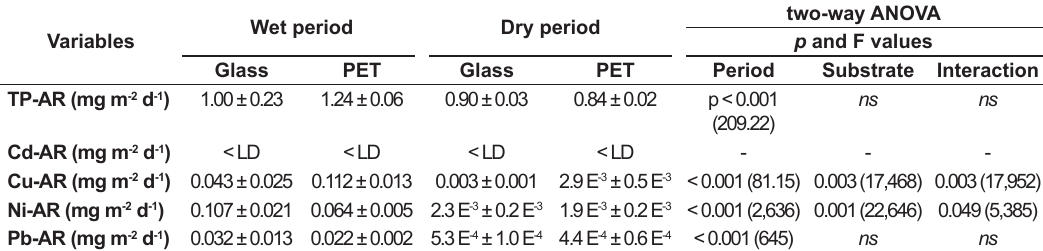
Figure 3. (A) Total phosphorus, TP; (B) Copper, Cu; (C) Nickel, Ni; and (D) Lead, Pb accumulation rates (mg m -2 d -1 ) on periphyton dry mass over glass and PET substrates in the wet and dry periods. Cd was bellow detection limit (0.003 mg L -1 ). Different letters indicate significant difference in ANOVA two-way followed by Tukey test (p < 0.05). Table 4. Mean and standard deviation (n = 3; SD) of the accumulation rates (AR, mg m -2 d -1 ) of total phosphorus and metals on glass and PET substrates during the wet and dry periods in a eutrophic shallow lake. Limit of detection (LD) to Cd was 0.03 mg L -1 ; ns = no significant difference. Statistical significance =